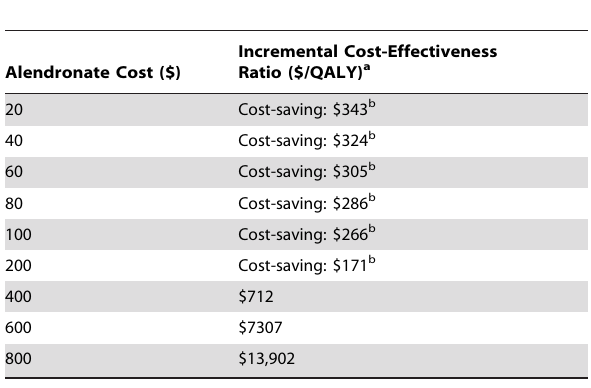
Table 1. Base-Case Analysis Results, Various Alendronate Costs.